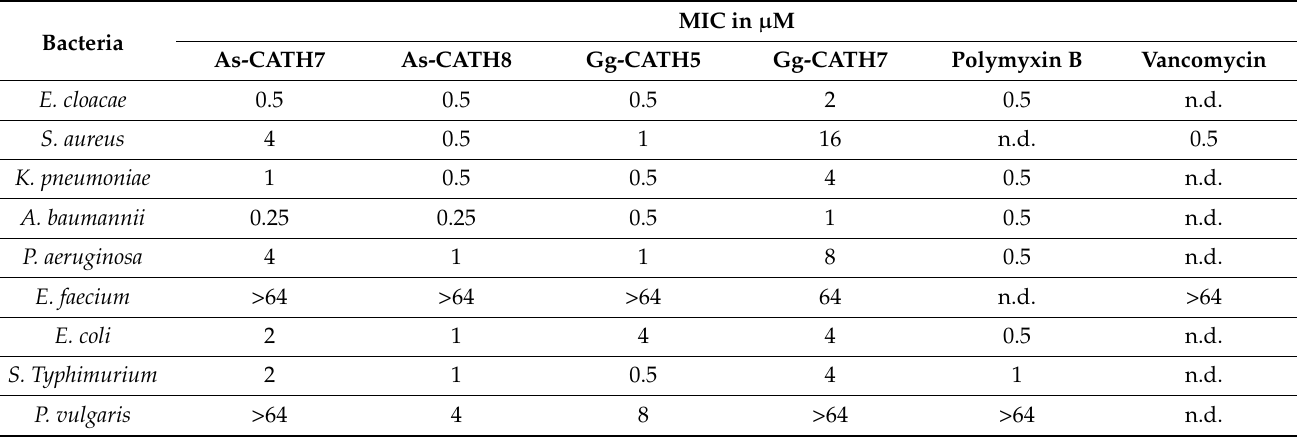
Table 2. Antimicrobial activity of the crocCATHs. The MIC values of the synthetic peptides were determined in a microdilution assay in MHB. The antibiotic vancomycin was used against Gram- positive S. aureus and E. faecium whereas polymyxin B was employed against the remaining Gram- negative strains. Values in µ g/mL can be found in Supplementary Table